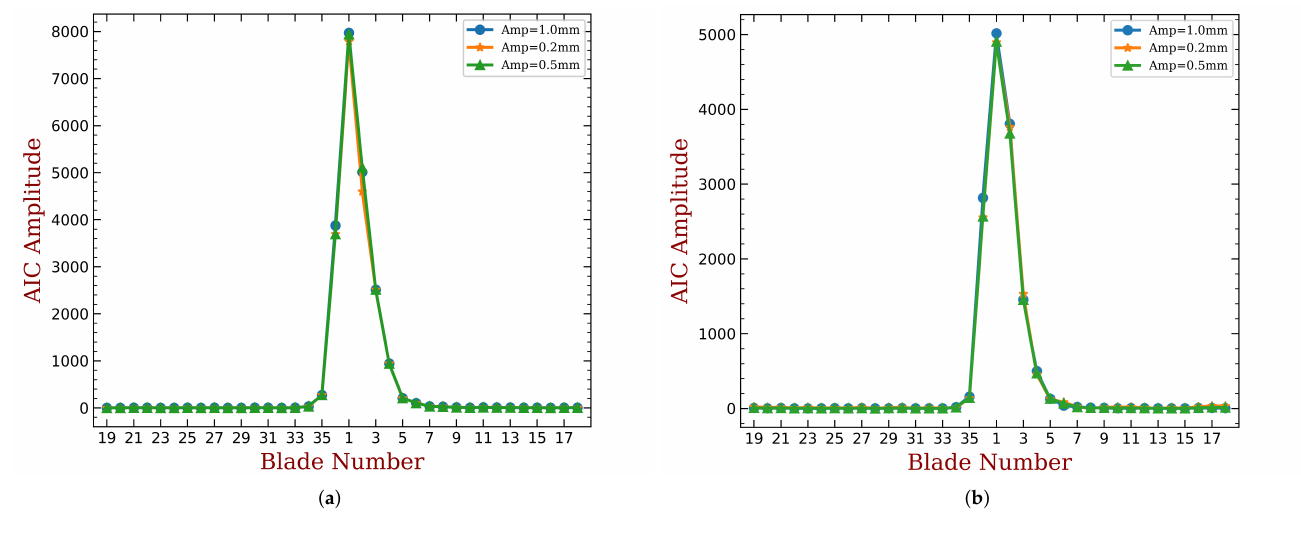
Figure 5. Aerodynamic influence coefficients computed with different blade amplitude a (please refer to Equation (13) for more details). Both conditions shown in Table 1 are computed. ( a ) Design point, ( b ) unstable point.